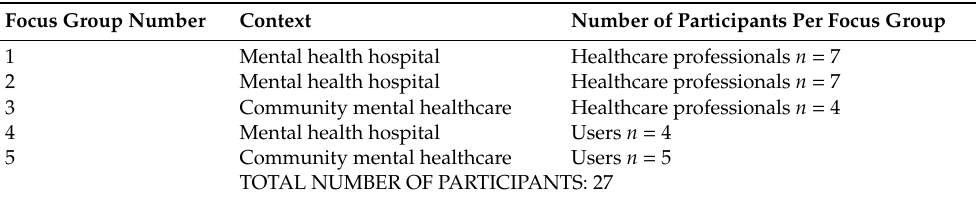
Table 1. Overview of the focus